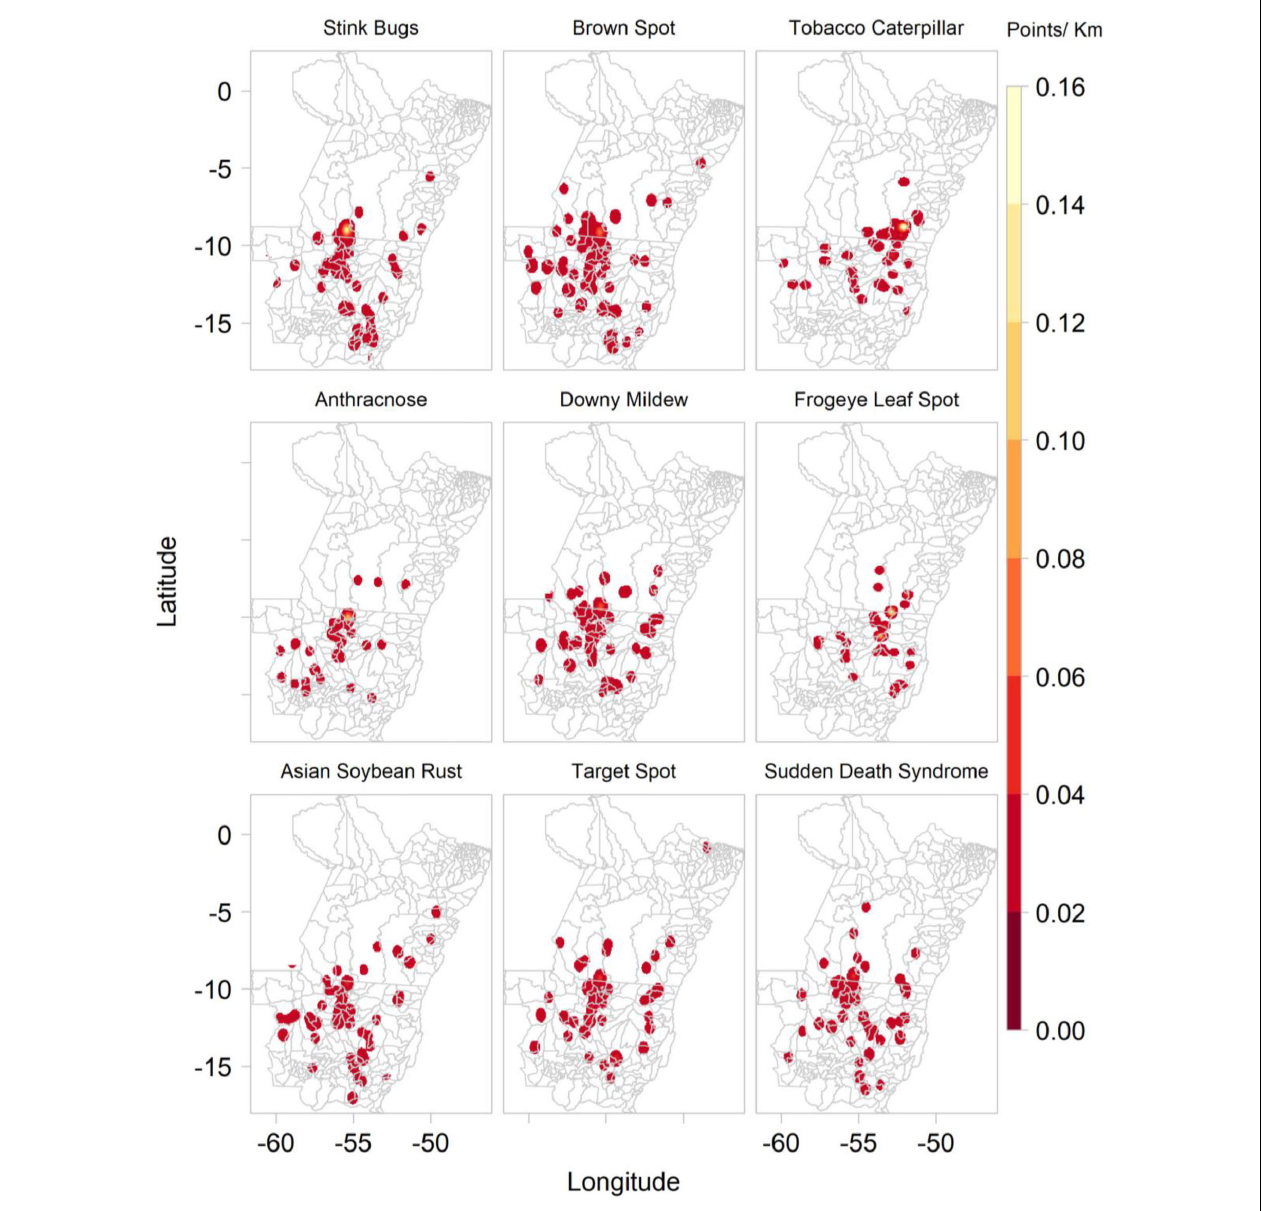
FIGURE 6 | Kernel density of main soybean pathogens and animal pests based on ConvNet predictions provided for images collected by Plantix users and agronomists in Mato Grosso and Pará, Brazil, between November 2016 and May